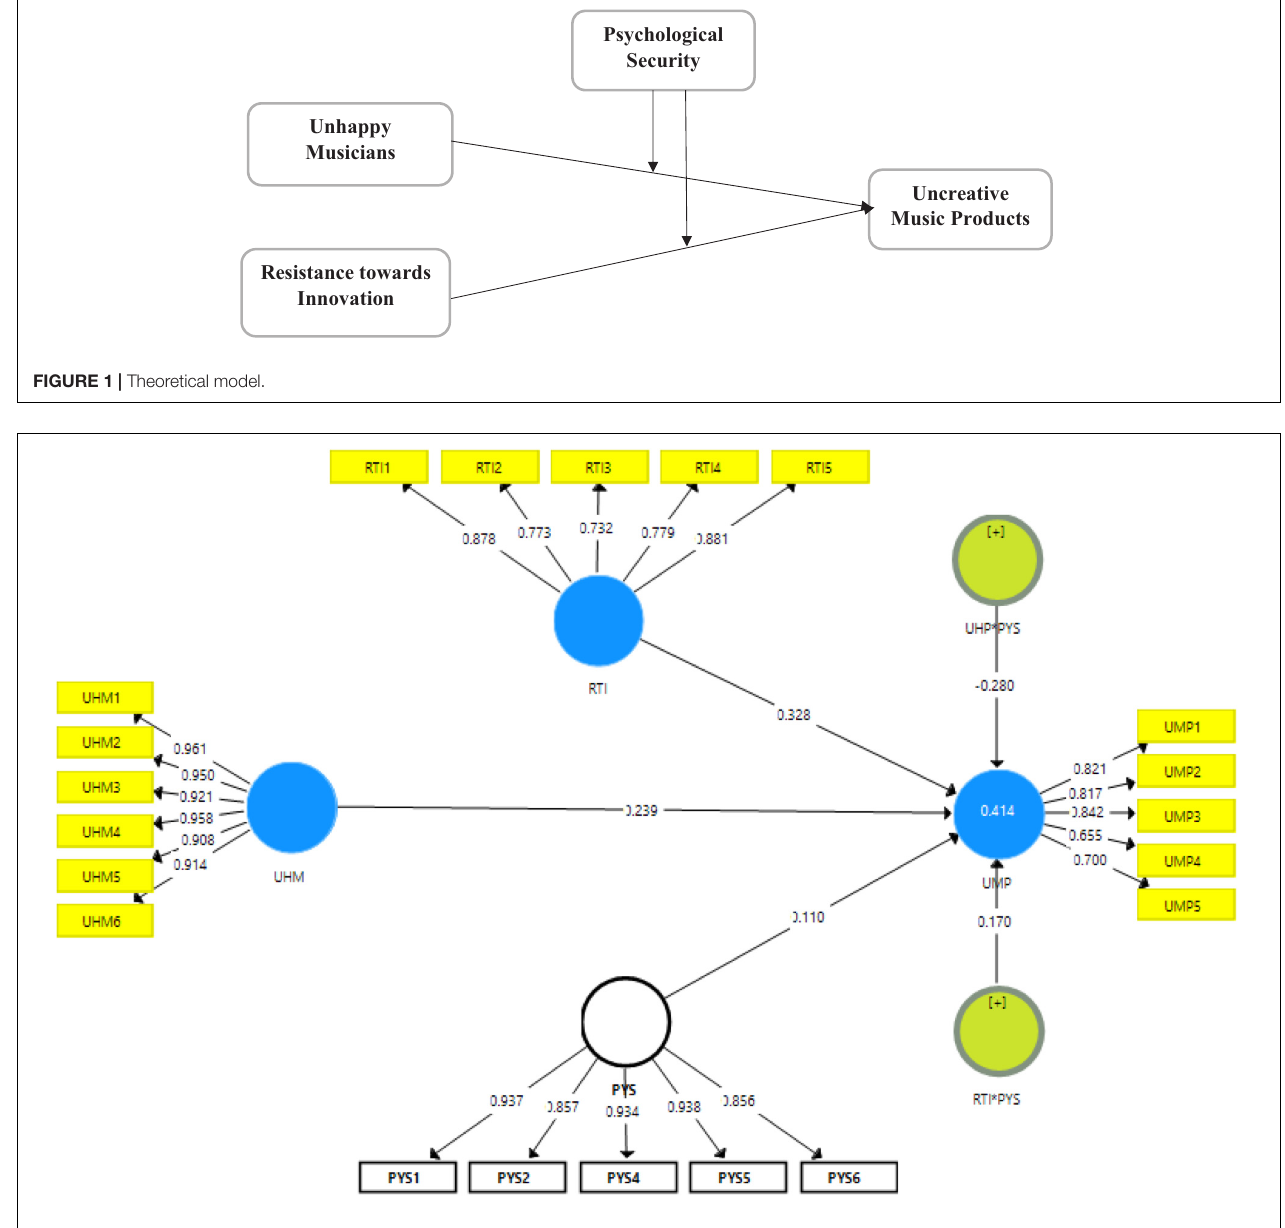
FIGURE 2 | Measurement model